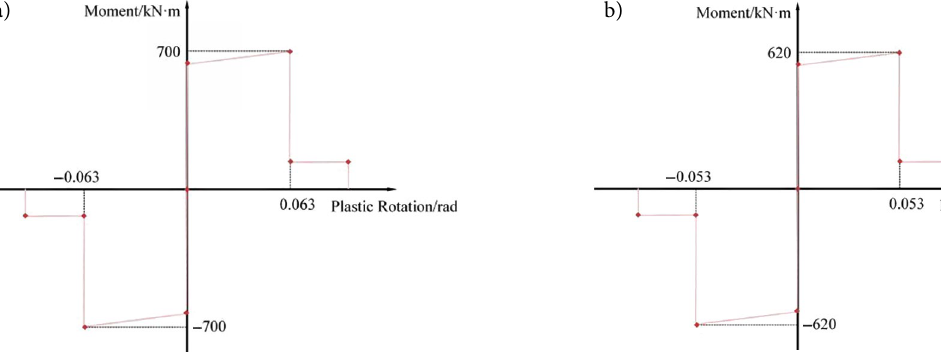
Figure 7. Plastic hinge M-Teta curves: a – PMM; b